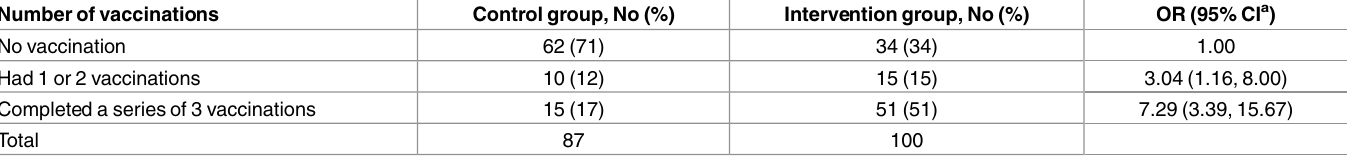
Table 3. HBV vaccinations amongAsian AmericansRandomized to intervention and controlgroups usingLay HealthWorkers: BaltimoreWash- ingtonMetropolitanArea, 2013–2014 (n = 187). Number of